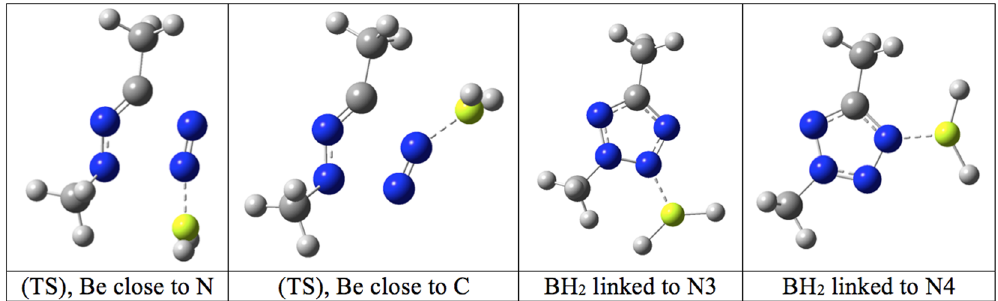
Figure 2. Transition states and products of the reaction between H 2 Be···N 2 and dimethyl nitrile imine at the G4MP2 level of